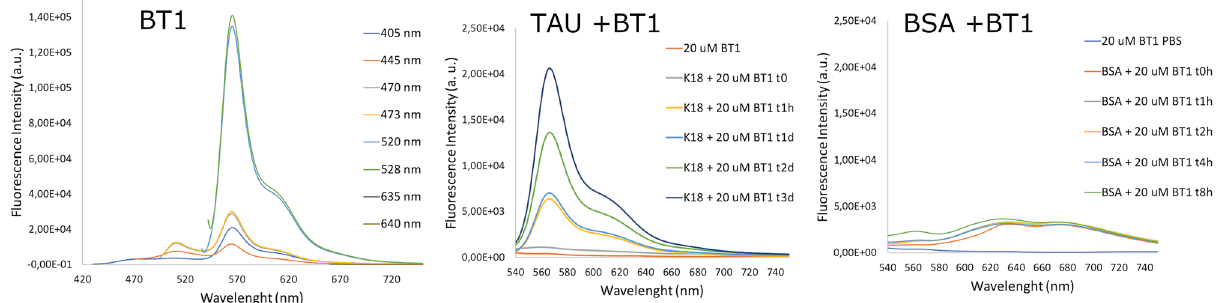
Figure 3. Fluorescence analysis of BT1. ( A ) Sample plot showing the emission spectra of synthesized BT1 (100 μM) in PBS buffer pH 7.4 and 1% DMSO according to the experimental conditions used for the immunostaining in human iPSC derived cortical neurons. The emission spectra were recorded at different λ ex as indicated in the legend on the right. ( B ) Representative plot showing the time-course of BT1 (20 μM) (λ ex = 520 nm) in the presence of unfibrillated K18 tau protein (70 μM) (t0) and fibrillated K18 upon induction with heparin (70 μM) after 1 h, 1 day, 2 days and 3 days at 37 °C. ( C ) representative graph reporting the